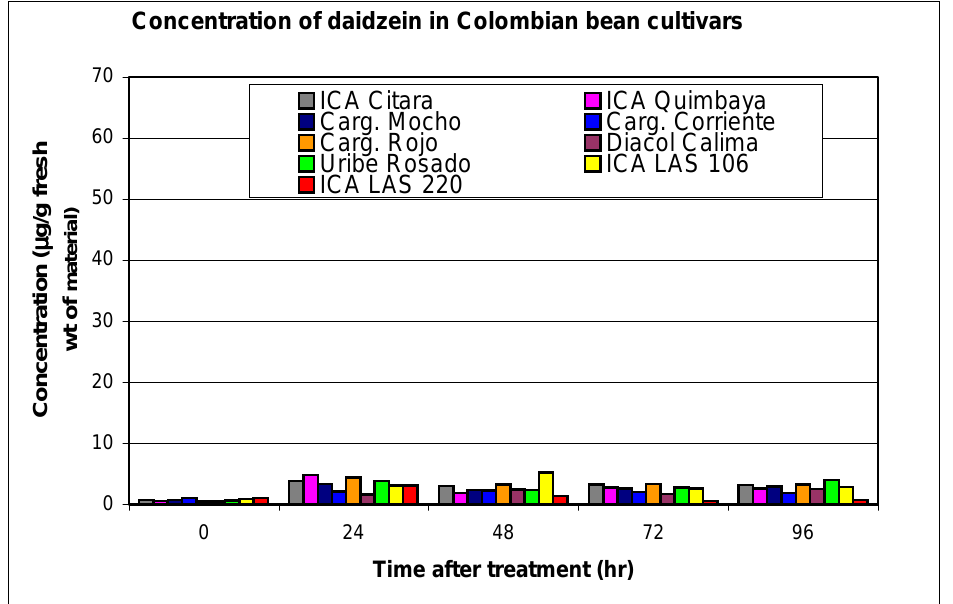
Figure 4. Time-course study of daidzein content in seedlings of different bean